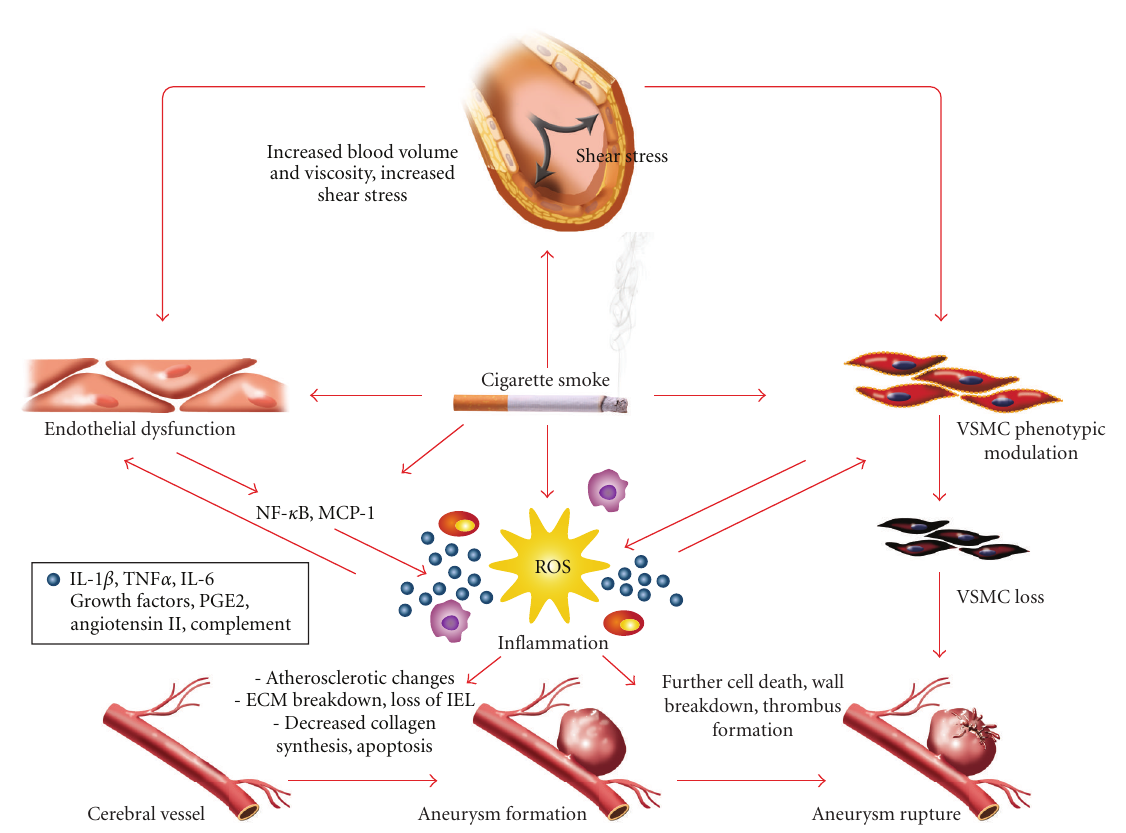
Figure 1: CS-associated inflammatory response in CA walls. CS increases wall shear stress in cerebral vessels and causes endothelial dysfunction with VSMC proinflammatory phenotypic modulation. The resultant inflammatory response implicates several inflammatory cells and mediators (ROS in particular) and leads to extracellular matrix remodeling and subsequent aneurysm formation. Further CS- induced matrix breakdown, cell death, and formation of an organizing thrombus eventually culminate in CA rupture. IEL: internal elastic